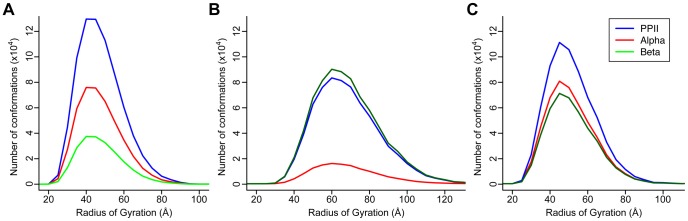
Relative abundance of sampled conformations.The relative frequency of PPII (blue line), α (red line) and β (green line) conformations in the (A) coil-sampled, (B) β-sampled and (C) 3-state ensembles. The frequencies are plotted against the radius of gyration that is binned into 5 Å windows.